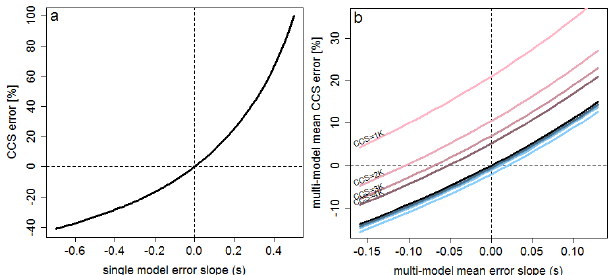
Figure 6. (a) Effect of the error slope on the single-model CCS. (b) Effect of the error slope on the multi-model mean CCS. Black line: covariance term of 0K; blue lines: covariance term of − 0.02K; pink lines: covariance term of + 0.21K. The lightest colors corre- spond to an error-free CCS of 1K, the darkest colors to a CCS of